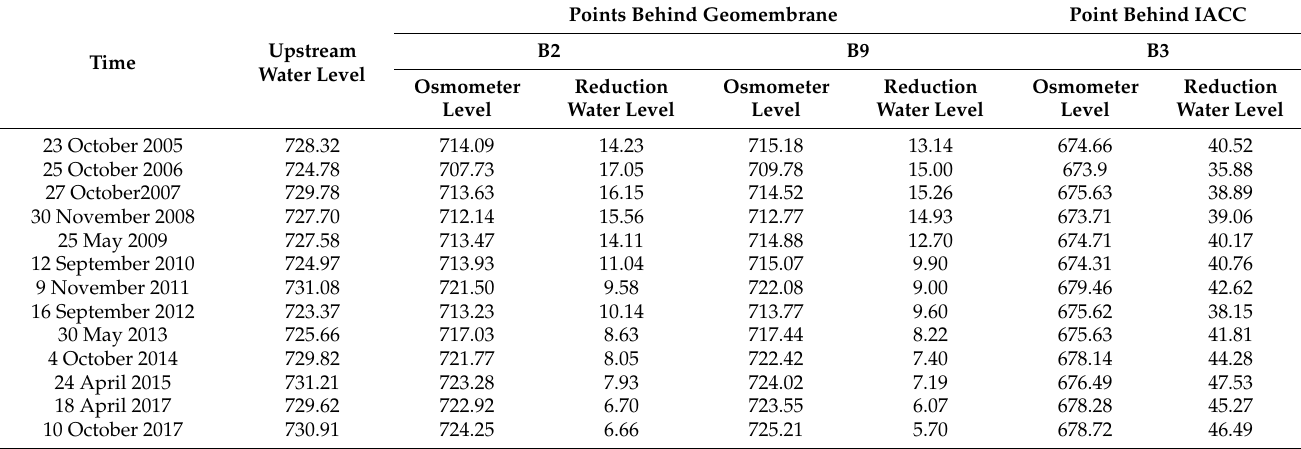
Figure 10: (1) The osmometer level of B3 fluctuates within 669.48~680.88 m, according to the upstream water level, and the average annual osmometer level of B3 is 674.30 m. (2)